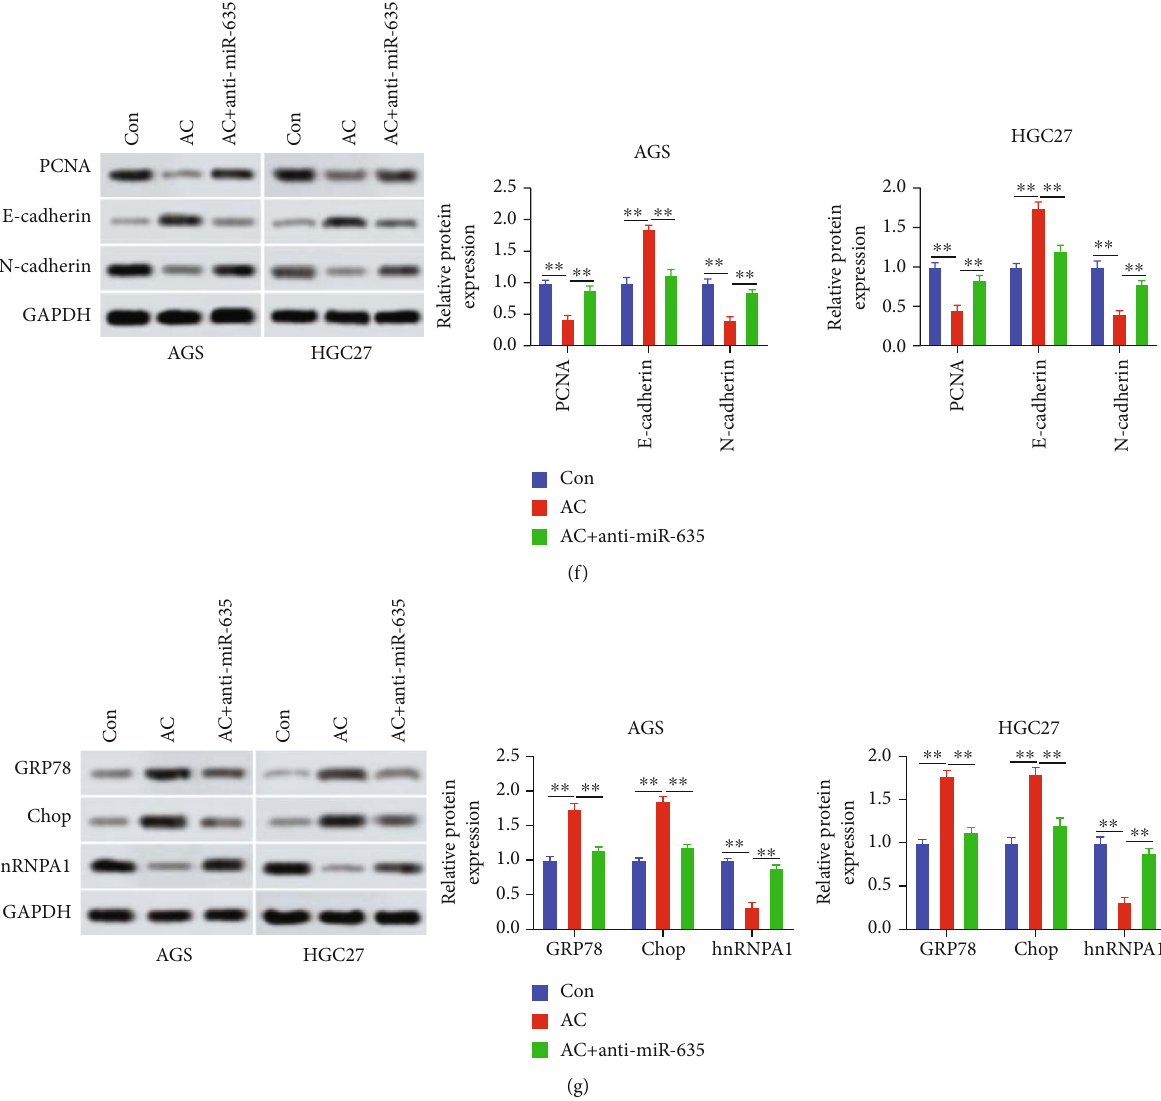
Figure 2: Asiaticoside suppresses gastric cancer aggressive behaviors and induced endoplasmic reticulum stress by upregulating the miR- 635 expression. (a) The miR-635 expression in GES-1, AGS, and HGC27 cells was assessed using qRT-PCR. (b) The miR-635 expression in AGS and HGC27 cells after treatment with AC was evaluated. (c) The miR-635 expression was tested utilizing qRT-PCR after cell treatment with AC and transfected with the miR-635 inhibitor. (d) Gastric cancer cell viability was assessed by the CCK-8 assay after AC treatment and miR-635 inhibitor transfection. (e) The migration capacity was evaluated by the Transwell assay after AC treatment and miR-635 inhibitor transfection. (f) The levels of PCNA, E-cadherin, and N-cadherin after AC treatment and miR-635 inhibitor transfection were determined by Western blot. (g) The levels of GRP78, Chop, and hnRNPA1 in AGS and HGC27 cells after treatment with AC and transfection with the miR-635 inhibitor were evaluated using Western blot. ∗∗ P < 0 : 01